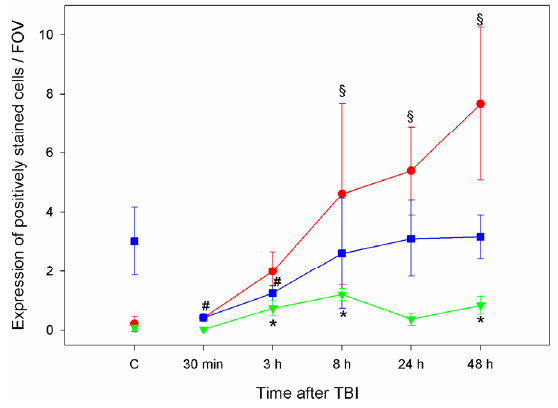
Figure 10. Line graph shows, iNOS ( red ), eNOS ( blue ) and NOS/ADMA ratio ( green ) expression in the perilesional zone at different time points after CCII as well as in controls (mean ± SD). § significant increase in iNOS expression. # significant decrease in eNOS expression 30 min and 3 h after TBI compared to controls as well as to 8, 24 and 48 h after TBI. * significant increase of NOS/ADMA ratio compared to